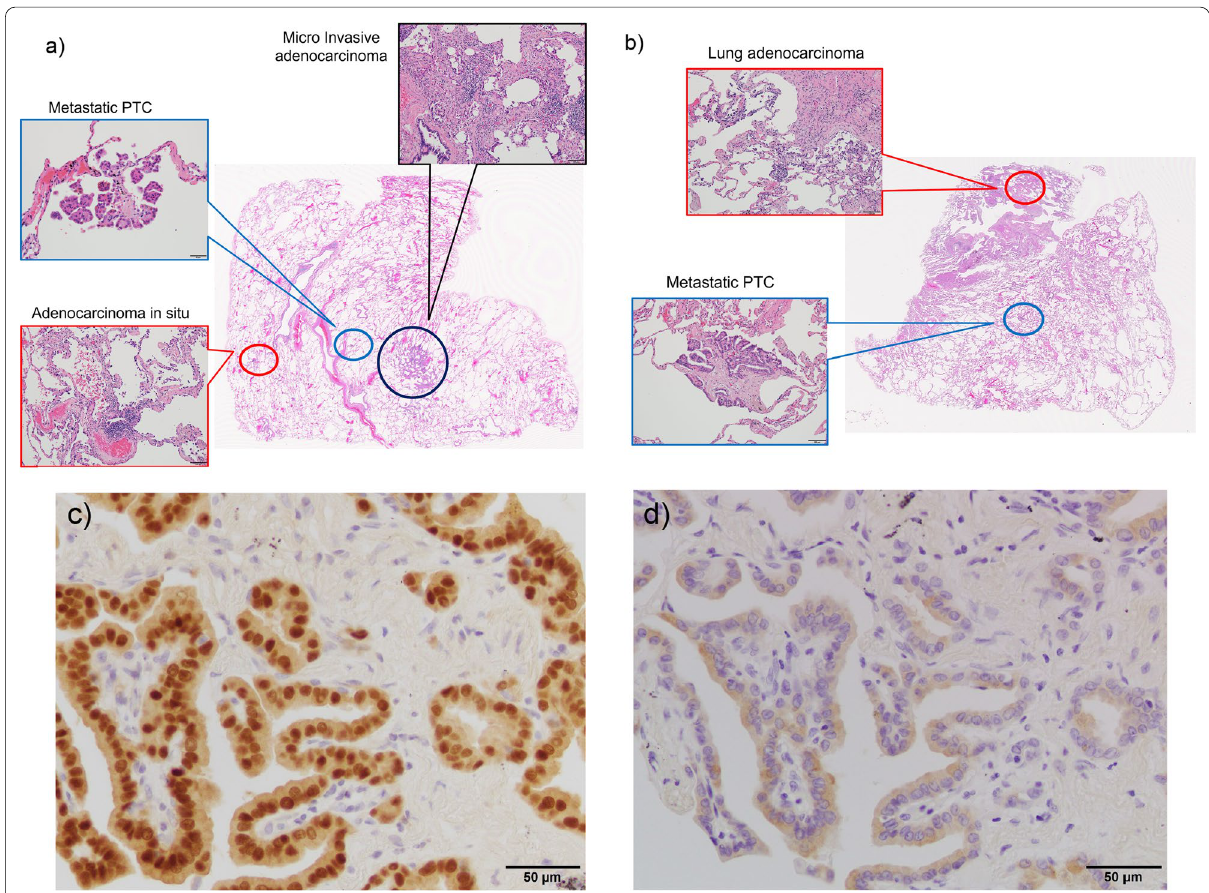
Fig. 2 Pathological findings of the lung tumor. a A loupe image of the right lung specimen (H&E staining). This shows the location of lung adenocarcinoma ( 100), adenocarcinoma in situ ( 100) and metastatic PTC ( 200). b A loupe image of the left lung specimen (H&E staining). × × × This shows the location of lung adenocarcinoma (